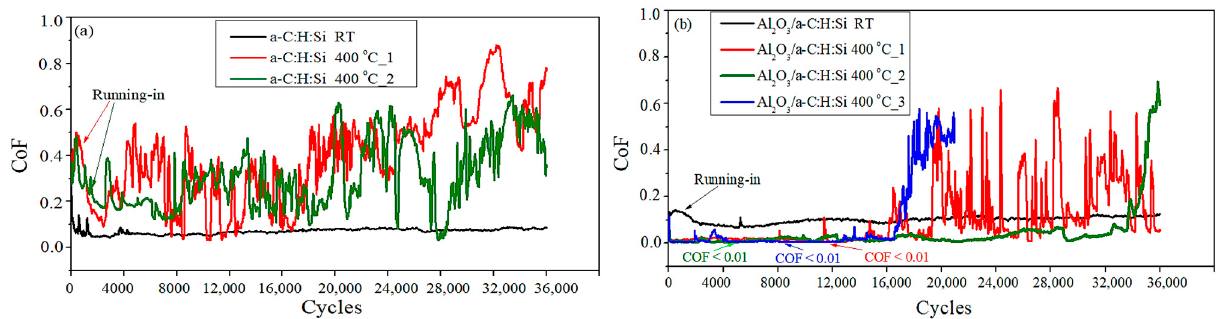
Figure 2. COF versus cycles curves taken on the ( a ) a-C:H:Si and ( b ) Al 2 O 3 /a-C:H:Si coatings.